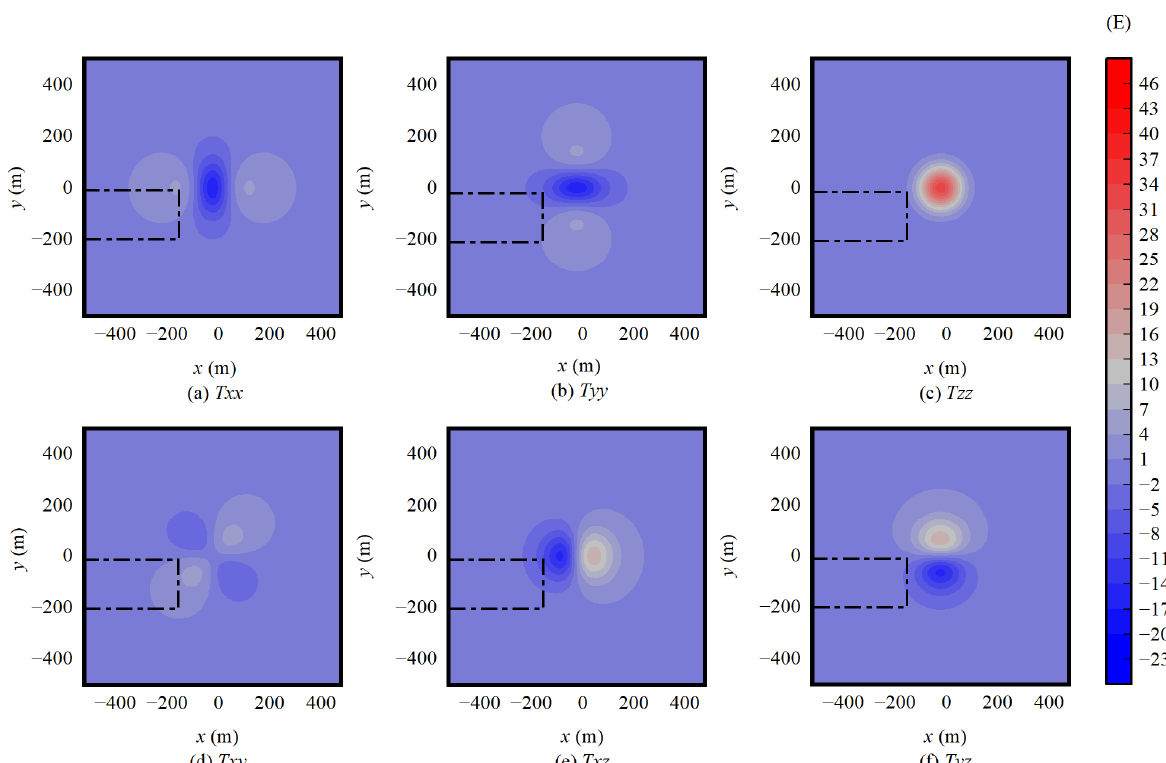
Figure 4. Simulate the full tensor gravity gradient caused by obstacles.